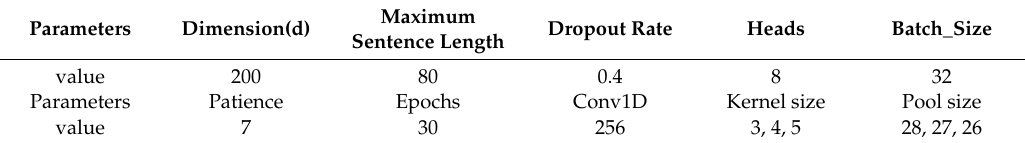
Figure 4. The frequency of different blog length. Table 5. Parameters in our experiment.